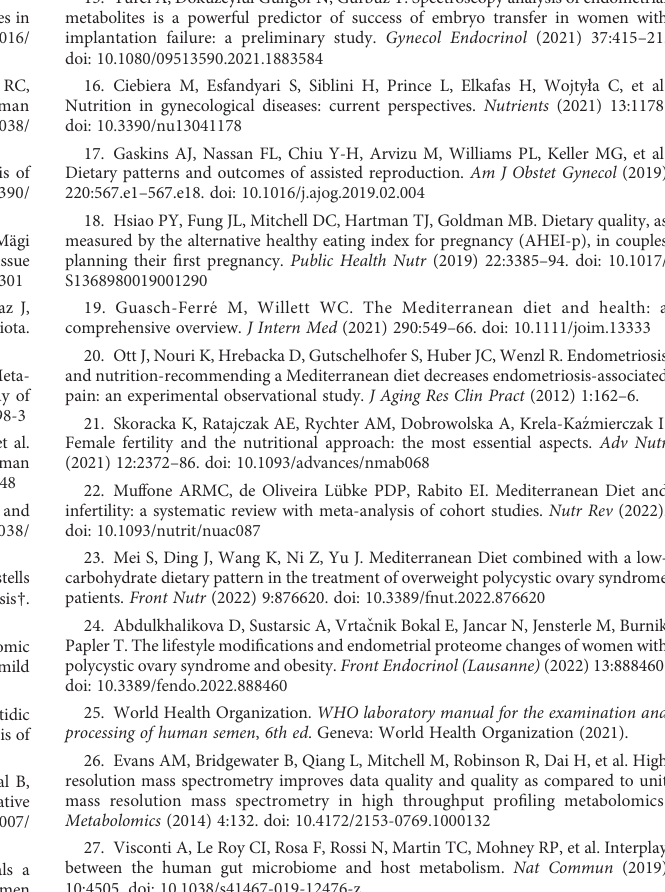
SUPPLEMENTARY TABLE 3 Statisticaldifferences inmetabolitesbetweengroupsbasedonMediterranean Diet (MD) adherence (i.e., high and low MD adherence). SUPPLEMENTARY TABLE 4 Correlation analyses between the Mediterranean Diet global score and the endometrial metabolome. SUPPLEMENTARY TABLE 5 Statistical differences in metabolites between groups based on uterine examination (i.e., women with no endometrial-factor infertility and patients with endometrial-factor infertility). SUPPLEMENTARY TABLE 6 Statistical differences in metabolites between groups based on folic acid supplementation. SUPPLEMENTARY FIGURE 1 Statistical difference in linolenate metabolite between women with high Statistical signi fi cance was set p-value<0.05 after FDR correction. EFI, endometrial-factor infertility; NEFI, no endometrial-factor